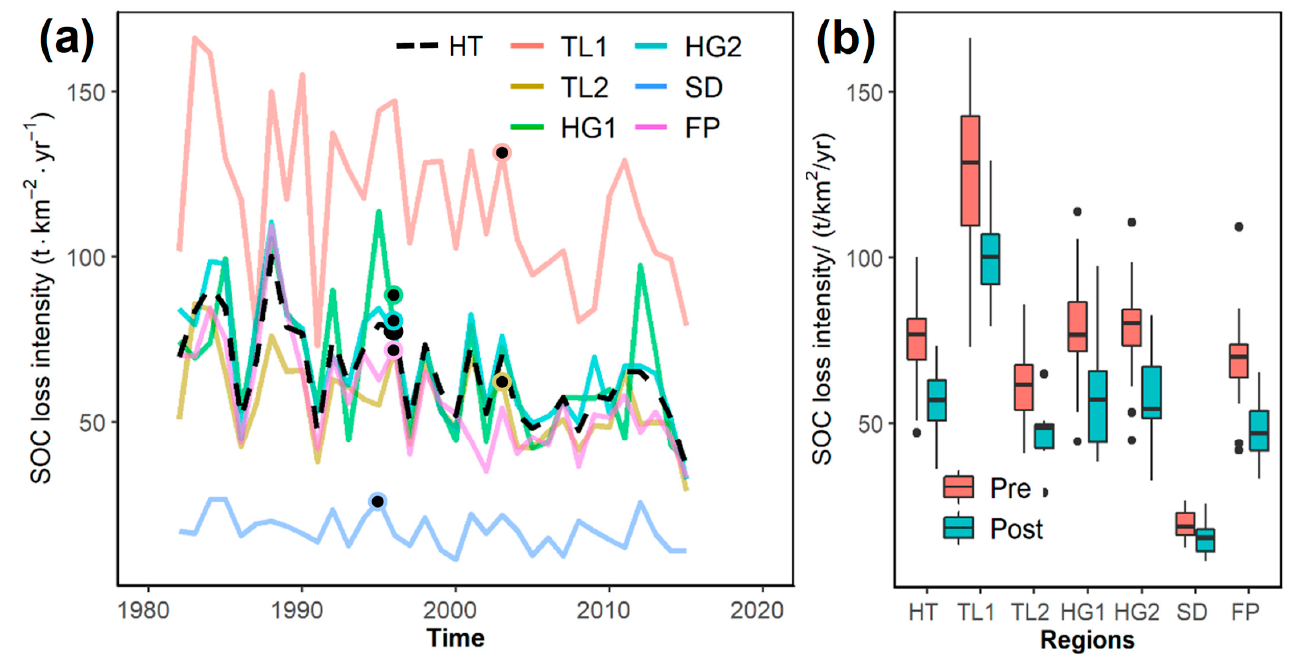
Figure 4. ( a ) Temporal change in SOC loss intensity in different regions and ( b ) relative change in SOC loss before and after the change-point year. HT, TL1, TL2, HG1, HG2, SD, and FP represent the Hetong region, and the six sub-regions, namely, two loess tableland sub-regions (TL1 and TL2), two loess hilly gully sub-regions (HG1 and HG1), sand sub-region (SD), and floodplain sub-region (FP), respectively. Black points in sub-figure ( a ) with different outline colors denotes the change-point year for the Hetong region and each sub-regions, respectively, and the ‘Pre’ and ‘Post’ in sub-figure ( b ) denotes the period before and after the change-point year. Table 1. Temporal changes in SOC loss intensity in the Hetong region and the six sub-regions.